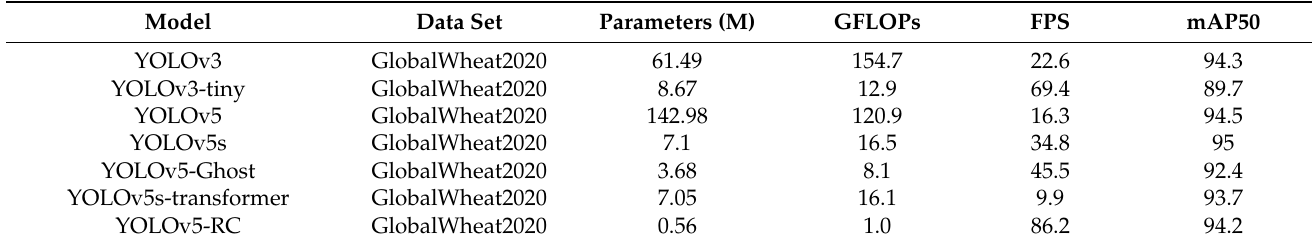
Table 7. Results for the data set